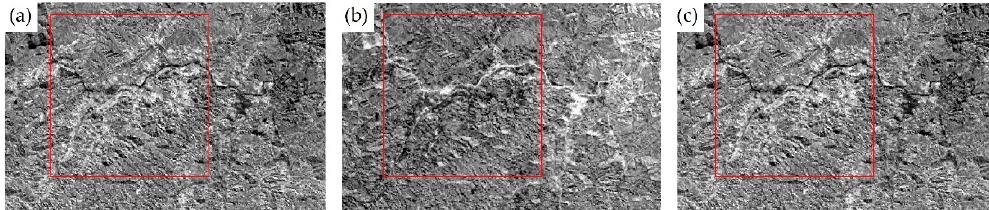
Figure 4. Results of tea vegetation index (TVI). ( a ) TVI 1 : the image calculated by the slope between wavelength 865 and 454 nm; ( b ) TVI 2 : the image calculated by the slope between wavelength 2032 and 1266 nm; ( c ) TVI 3 : the image calculated by the triangle area enclosed by wavelength 454, 1006, and 2032 nm.